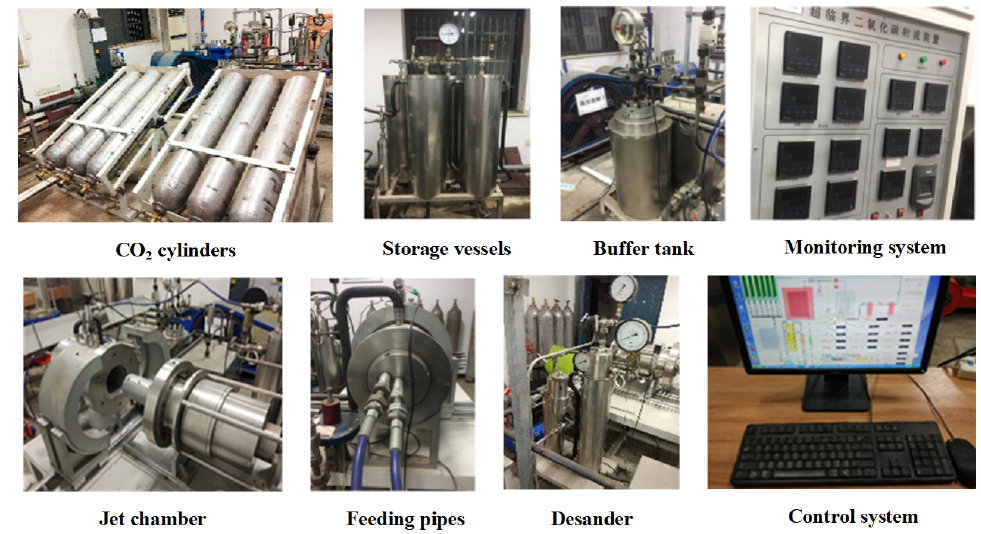
Figure 2. Photos of the main components of the experimental apparatus.